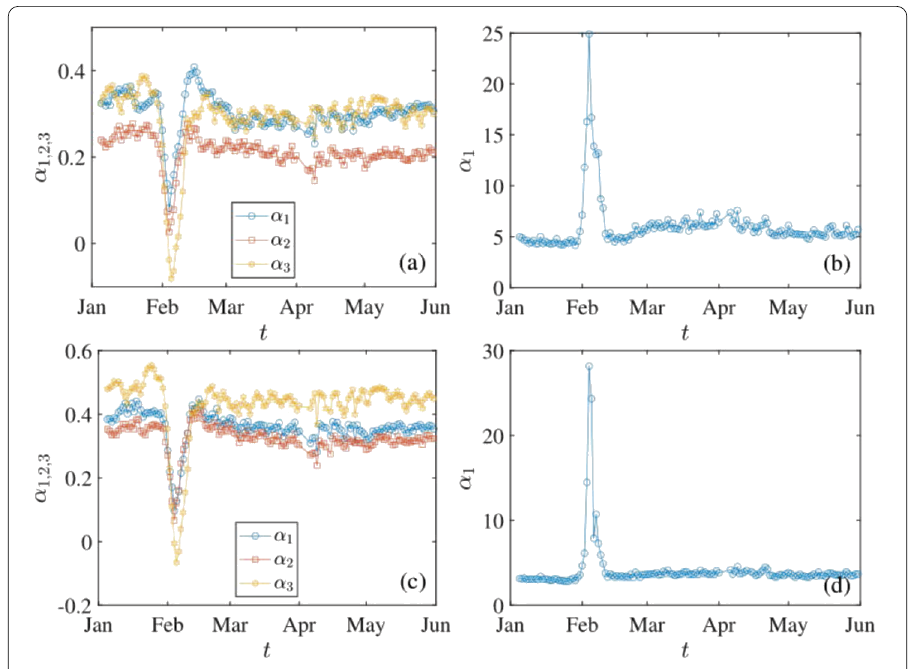
Figure 18 Evolution of the exponents of daily directed and undirected freight highway transportation networks. ( a ) Scatter data of F ij with respect to P α 1 with respect to P α 1 P α 2 / d α 3 for the directed network. ( c ) Scatter data of W ij with respect to P α 1 i j ij undirected network. ( d ) Binning data of W ij with respect to P α 1 i P α 2 j / d α 3 ij for the undirected